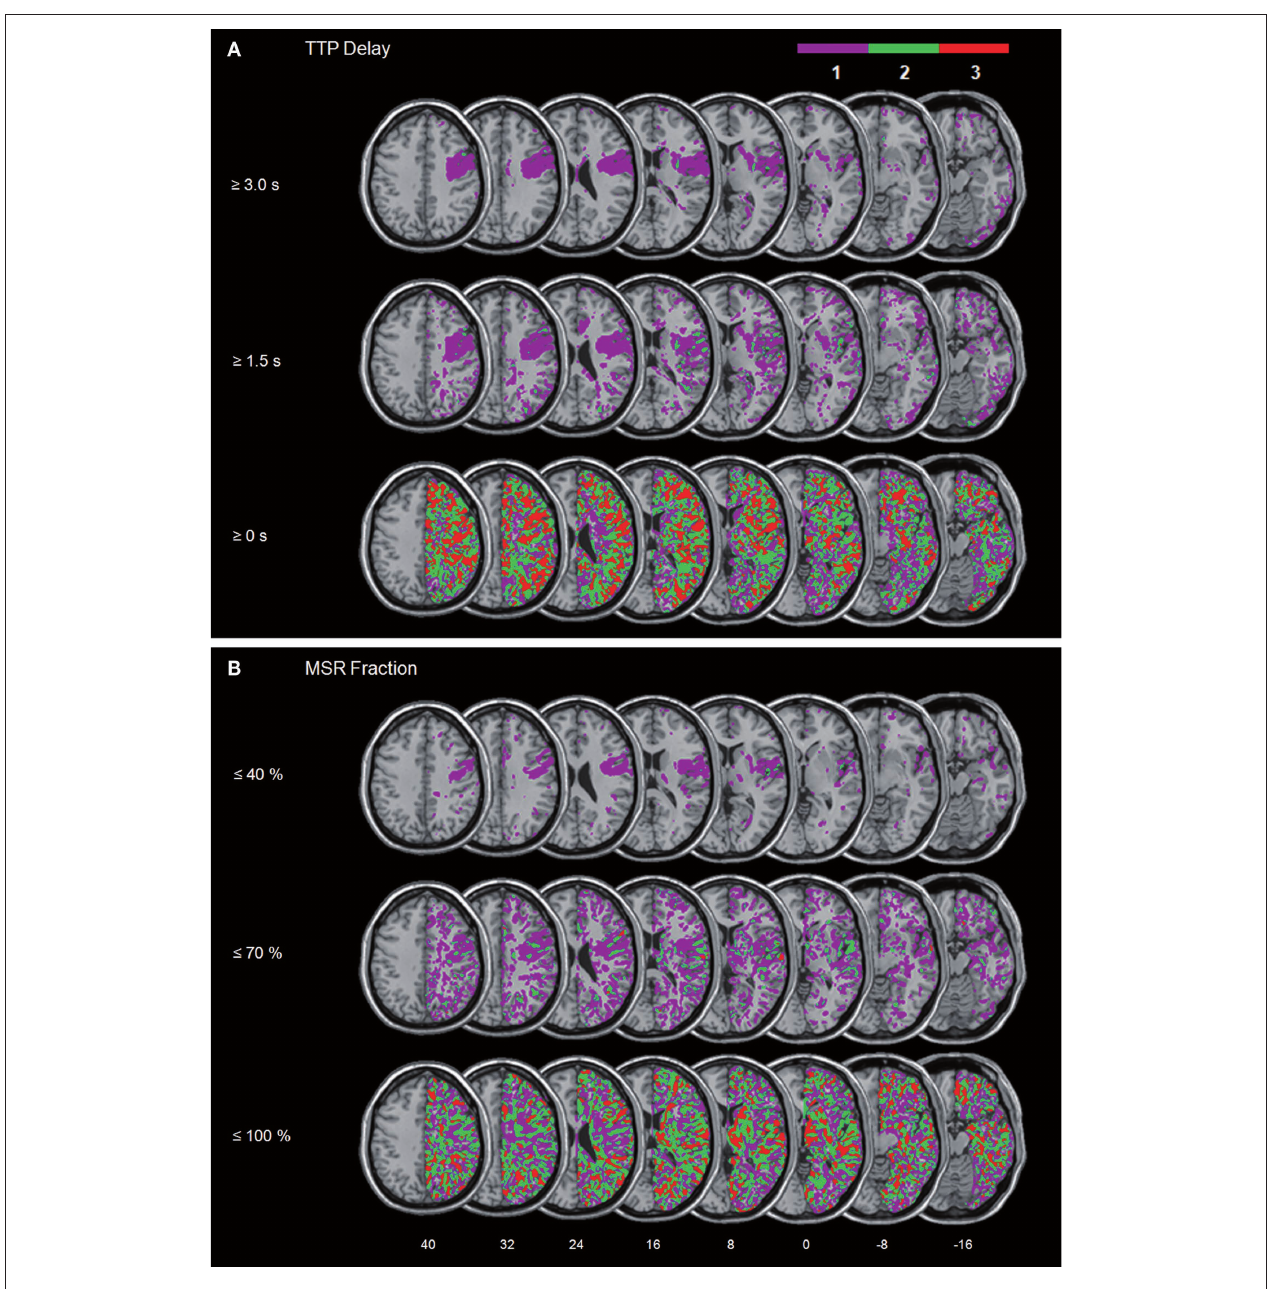
overlapping areas are illustrated by different colours coding increasing frequencies from violet ( n = 1) to red ( n = 3). MNI z -coordinates of the transverse sections are